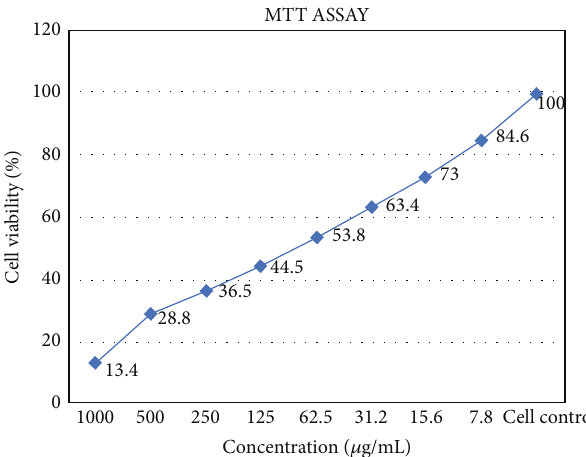
Figure 8: Graphical representation of polymer on MCF-7 cancer cell